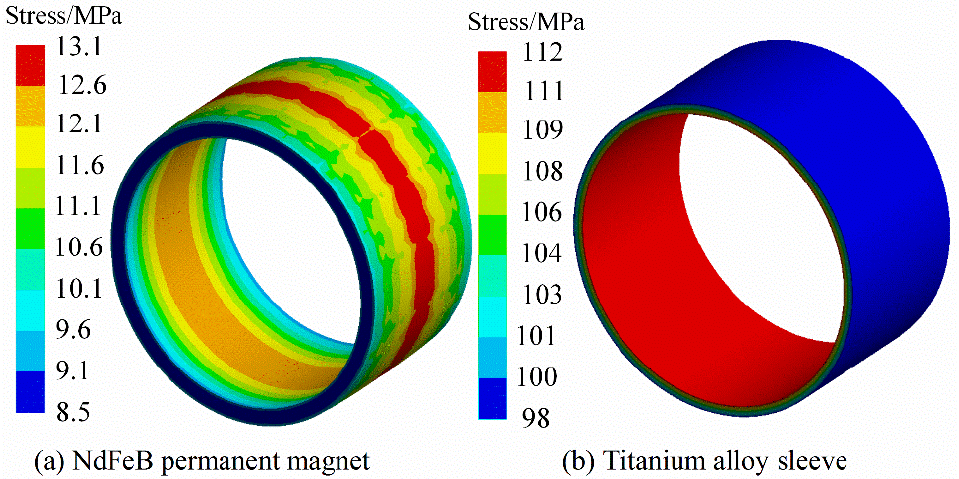
Figure 8. Von-Mises stress distribution of NdFeB PM and sleeve under cold rotating condition.